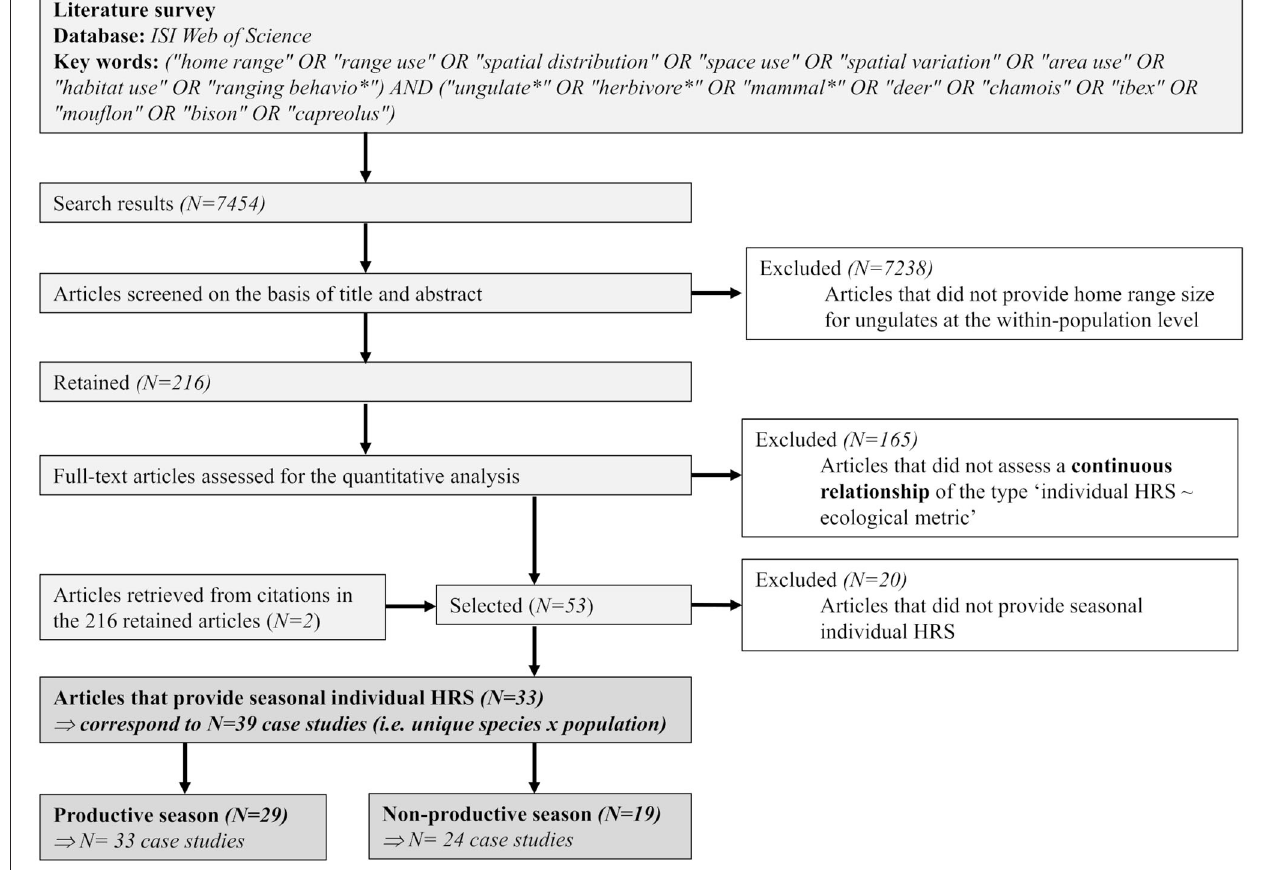
FIGURE 2 | PRISMA flow diagram, according to the PRISMA statement by Liberati et al. (2009) and recommended by Nakagawa and Poulin